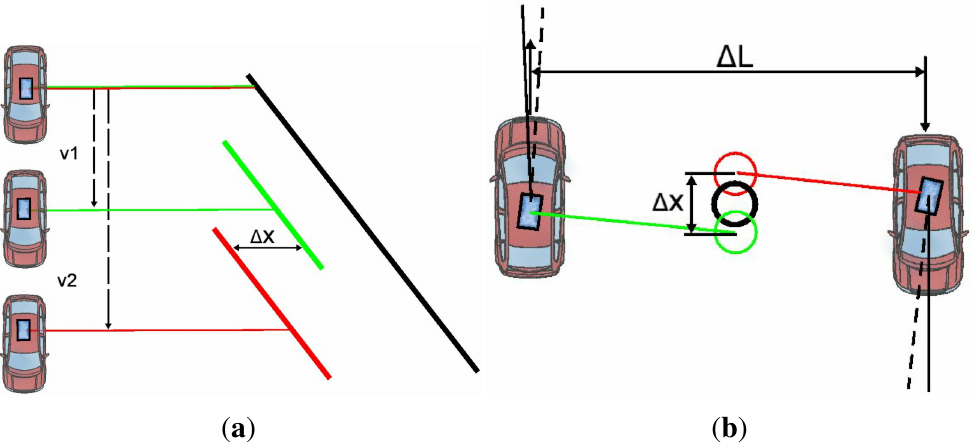
Figure 5. Configuration for the calibration of time offset and yaw angle offset. The vehicle is driven by an object at two different speeds to observe the timing error. The timing error is then derived from the geometric errors. To determine the azimuth error, a round object should be passed by from two sides. The offset between the two objects is then used to estimate the azimuth error. ( a ) Time; ( b )